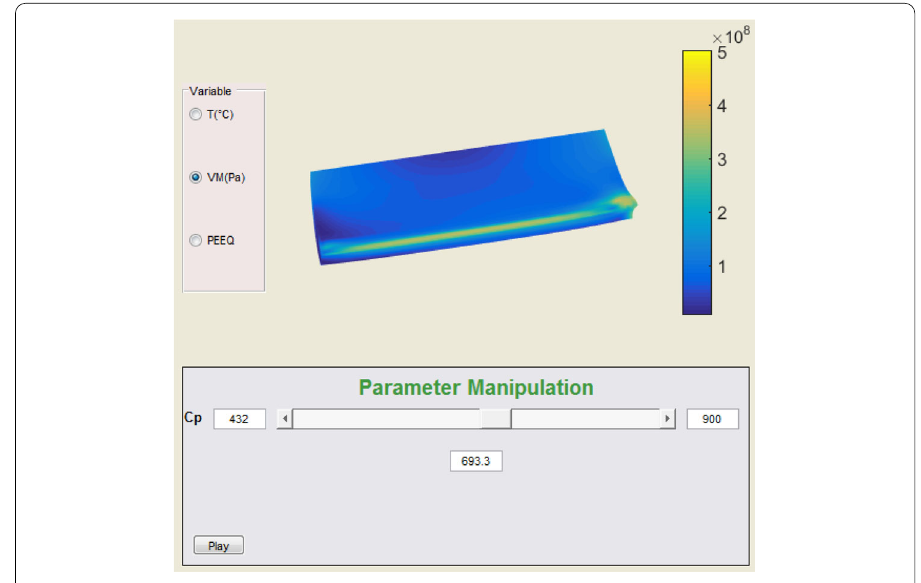
Fig. 12 Demonstrator of Space–time computational vademecum developed in matlab Table 4 CPU time for a new solution Phase Proposed approach (6 snapshots, error < 1%) Standard FEM Offline ≈ 42 h – Online < 0 . 2